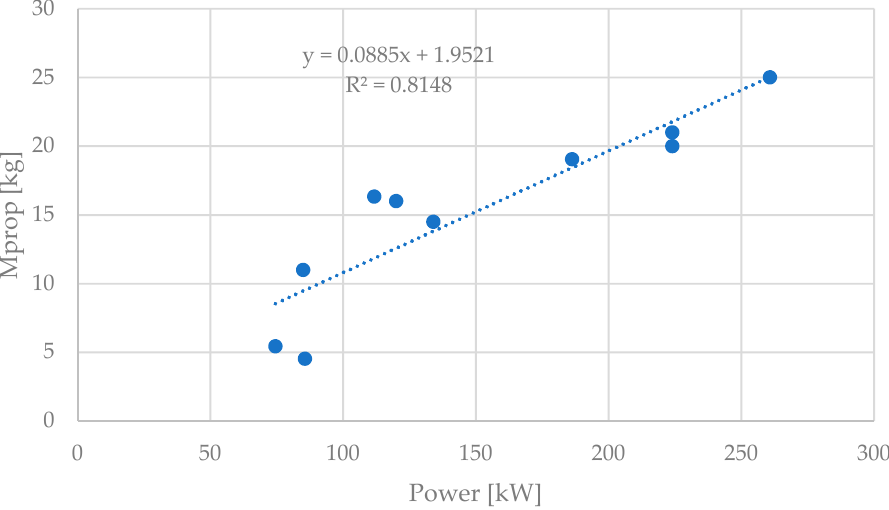
Figure 8. Scatter plot of samples and linear regression model of the propeller mass vs maximum power absorbed by the propeller.